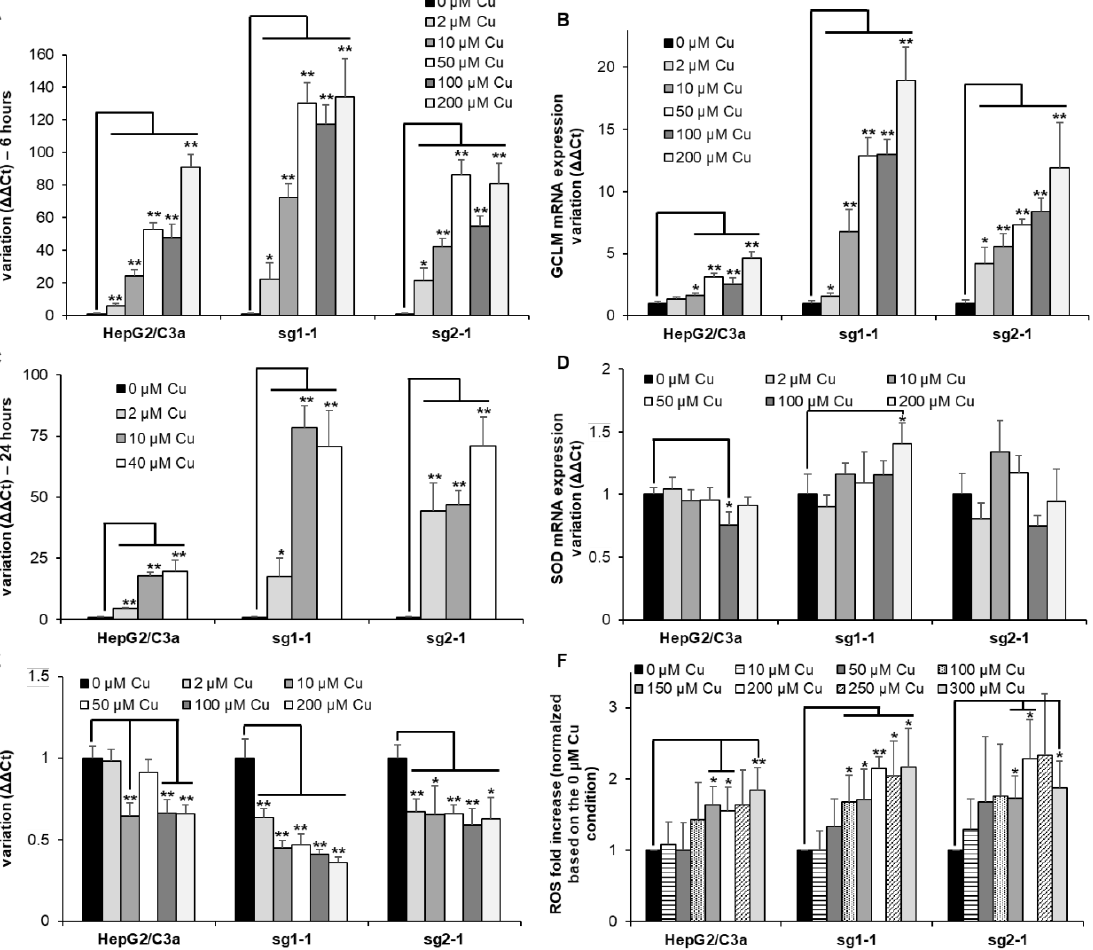
Figure 5. Metal and redox stress responses in cell lines with or without ATP7B. HepG2/C3a, sg1-1, and sg2-1 cells were exposed to increasing concentrations of Cu. Met (Met1X) ( A ), GCLM ( B ),